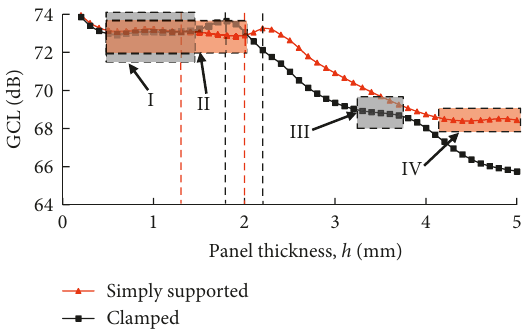
Figure 7: Effect of panel thickness on the global coupling level of the panel-enclosure coupled system with different panel boundary